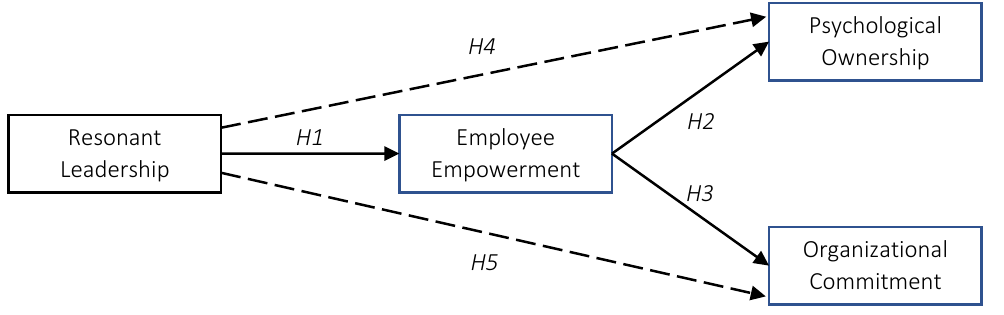
Figure 1. Theoretical